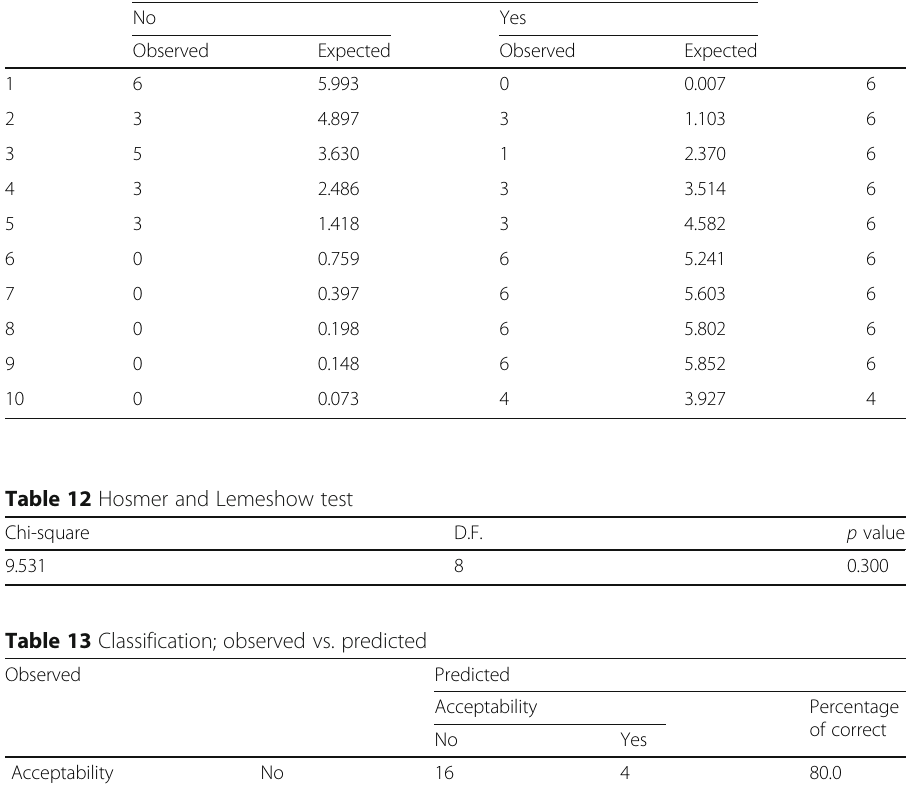
Table 11 Contingency table for Hosmer and Lemeshow test K